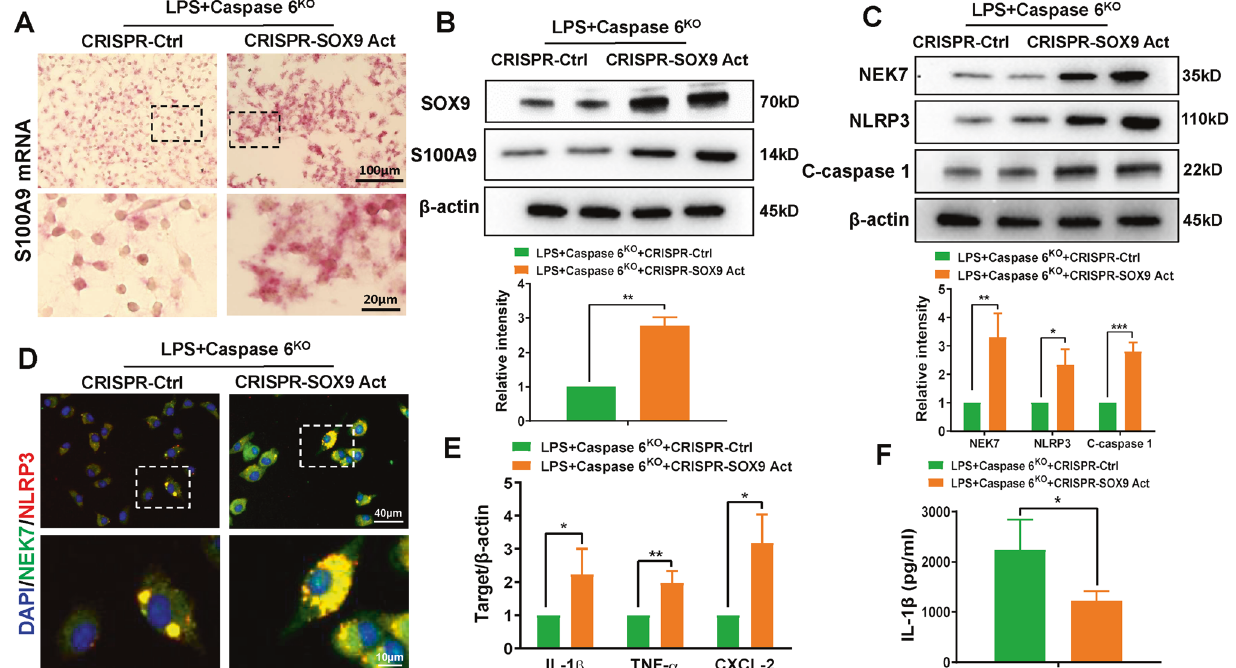
Fig. 6 SOX9 is necessary for NR4A1 to mediate S100A9 transcription in macrophages during Caspase 6-mediated in fl ammation. BMMs were isolated from Caspase 6 KO and WT mice and transfected with the p-CRISPR-SOX9 activation or control vector followed by LPS stimulation. A RNA-ISH detecting S100A9 mRNA in macrophages by using speci fi c probe; ( B ) Western blotting and relative intensity of SOX9 and S100A9; ( C ) Western blotting and relative intensity of NEK7, NLRP3 and C-caspase 1; ( D ) IF staining for NEK7 and NLRP3 expression in macrophages. DAPI was used to visualize nuclei. Scale bars: 40 μ m, 10 μ m; ( E ) Detection of cytokines IL-1 β , TNF- α and CXCL-2 by qRT-PCR in macrophages; ( F ) ELISA analysis of IL-1 β levels in culture medium. N = 4 – 7/group, all data represent the mean ± SD, * p < 0.05, ** p < 0.01, *** p < 0.001.